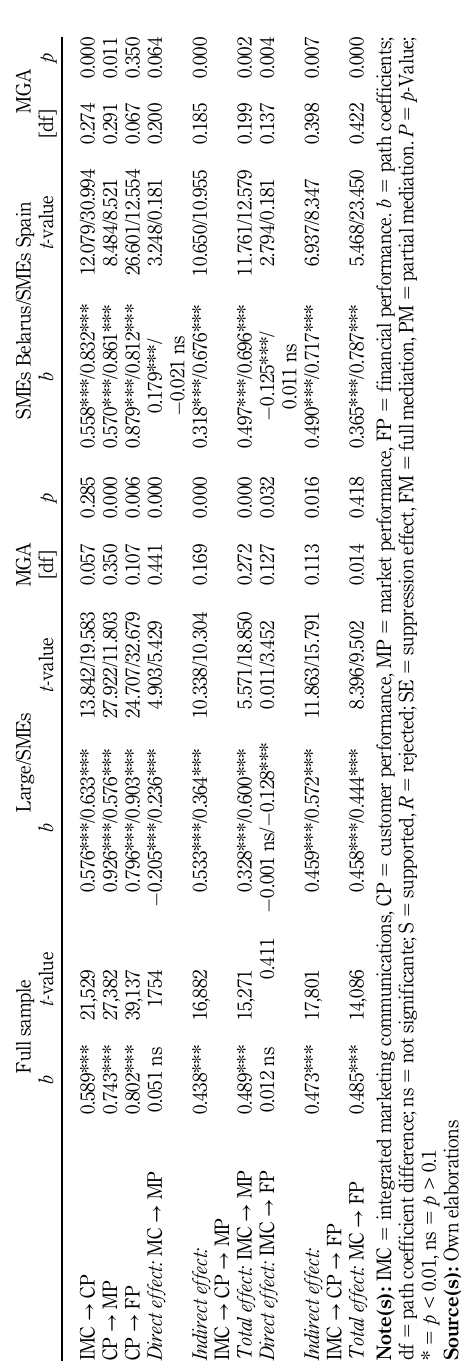
Table 4. Evaluation of the structural